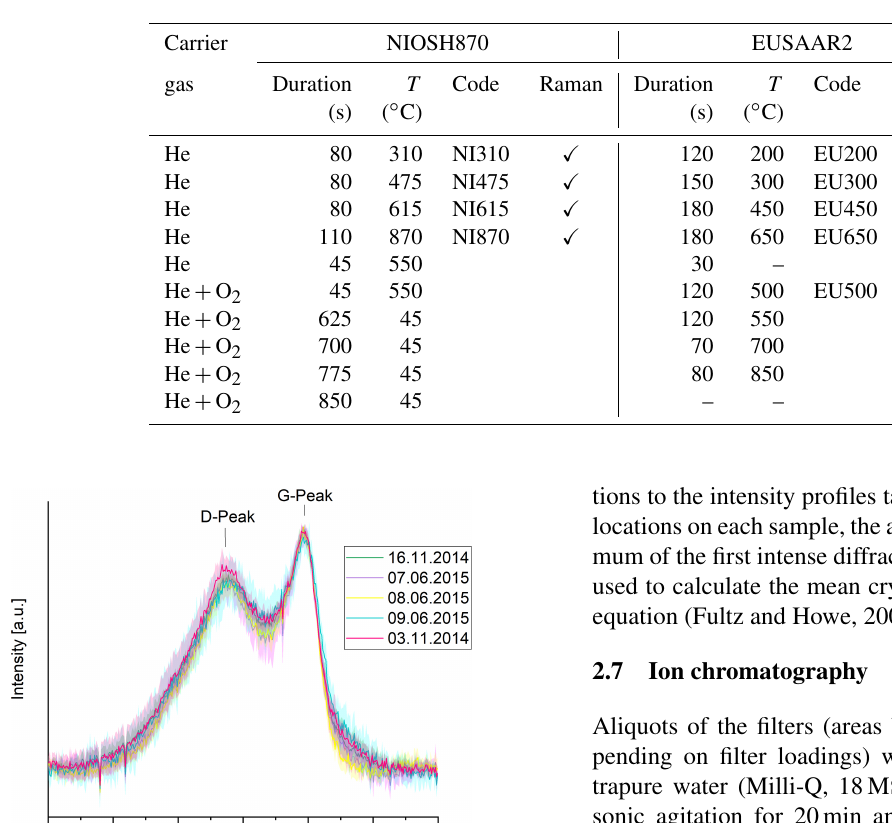
Table 1. Duration times, temperatures and gas atmospheres for the two different thermal–optical measurement protocols (NIOSH870, EU- SAAR2). The “Raman” column indicates that heated samples were analyzed with Raman spectroscopy for the respective temperature (see below). The codes are used when we refer to samples heated to a certain temperature – symbolized by the numeric index – following NIOSH870 (NI) or EUSAAR2 (EU).